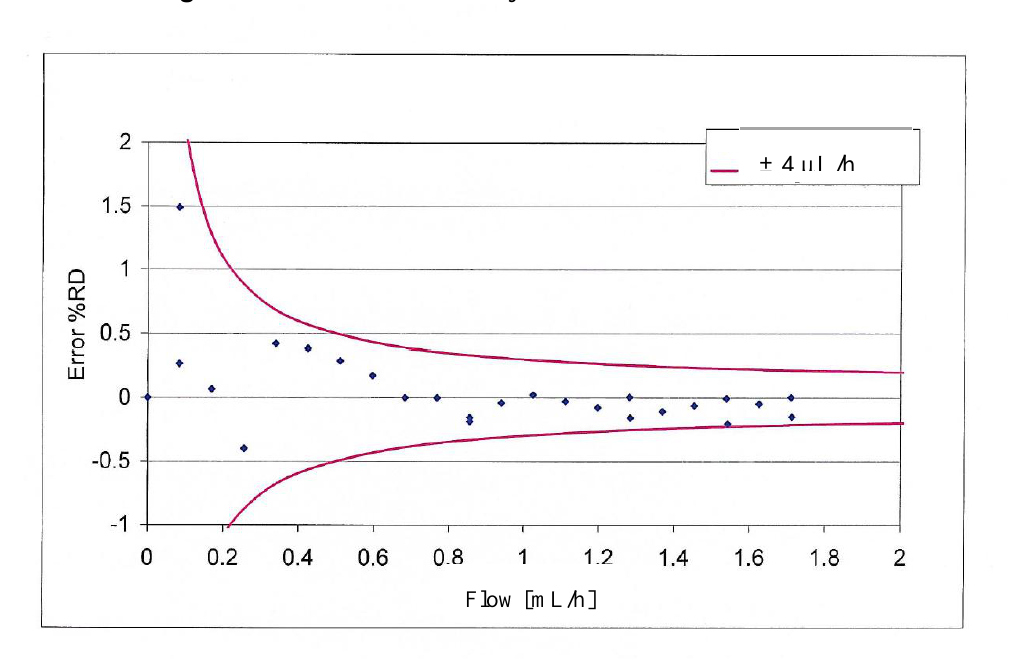
Figure 10. Measured accuracy of the Coriolis flow